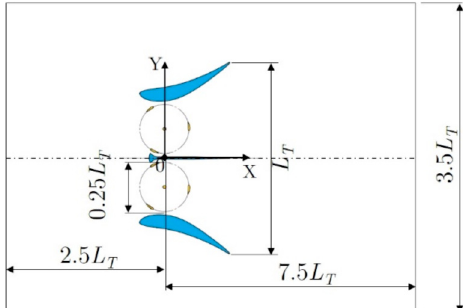
Fig. 8. Isolated HPS in a channel. Overview of the 2D computational domain. The computational mesh of the sole rotor region contains 110,000 cells while the remainder of the domain, outside the rotor region, contains about 135,000 cells resulting in a total number of cells approximately equal to 245,000.